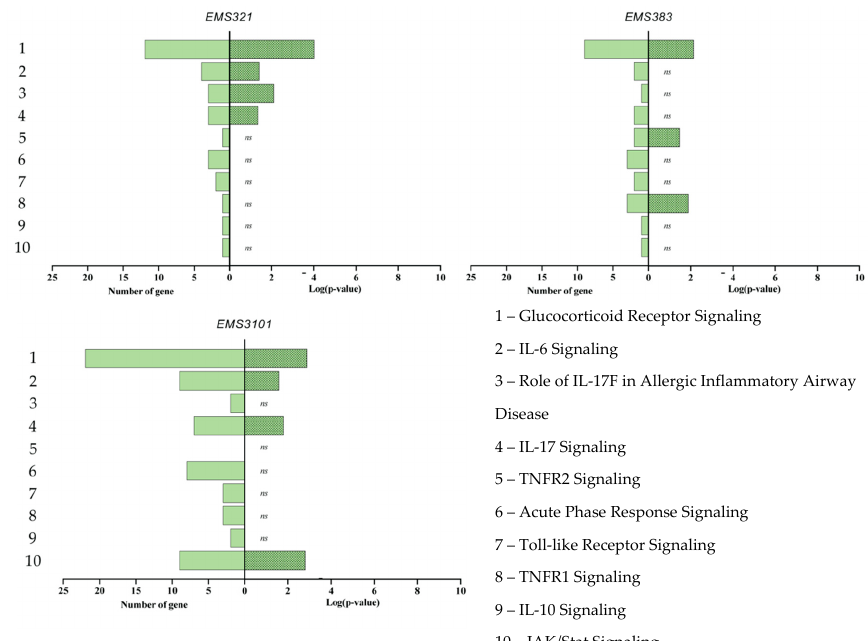
Figure 7. Significant canonical pathways of inflammation and the immune system modulated in BEAS-2B cells by our BC bacteria. Strains are identified as follows: EMS , Streptococcus strains; EME , Enterococcus strains. Fold change cutoff = 1.5. The y -axis is the –log( p- value), as produced by IPA, and the x -axis is the pathways modulated in BEAS-2B cells. The canonical pathways are predicted pathways that are changing based on gene expression; the higher the -log( p- value) is, the less likely the association is random.